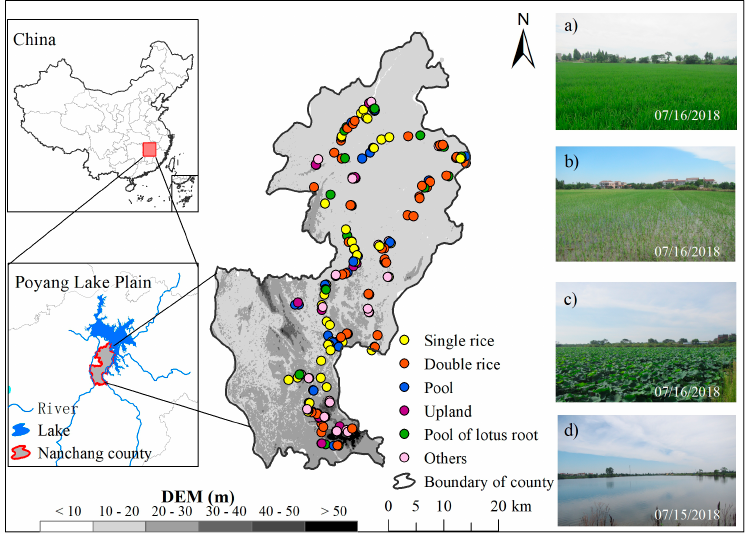
Figure 1. Location of field survey sites in the study area and photos that show examples of ( a ) single-cropping rice, ( b ) double-cropping rice, ( c ) lotus root, and ( d ) a water pool.